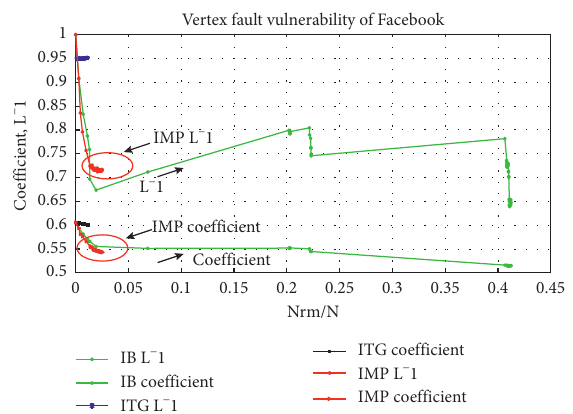
Figure 19: l − 1 & C G �( V,E ) result of Facebook.